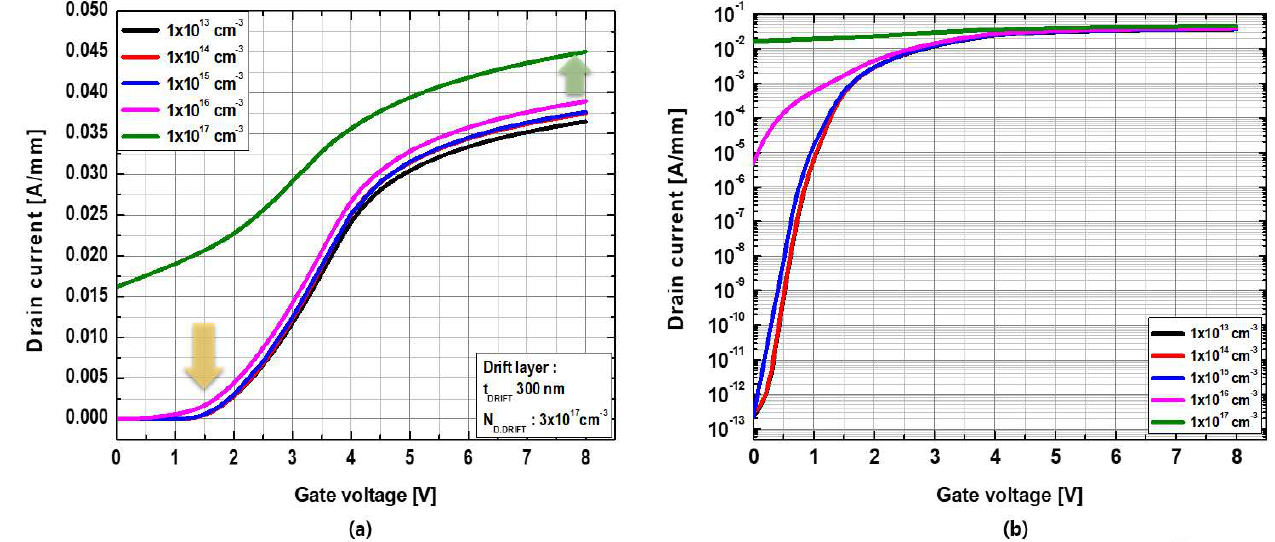
Figure 4. ( a ) Linear and ( b ) logarithmic transfer characteristics at V DS = +5 V as a function of the doping concentration of the body layer.